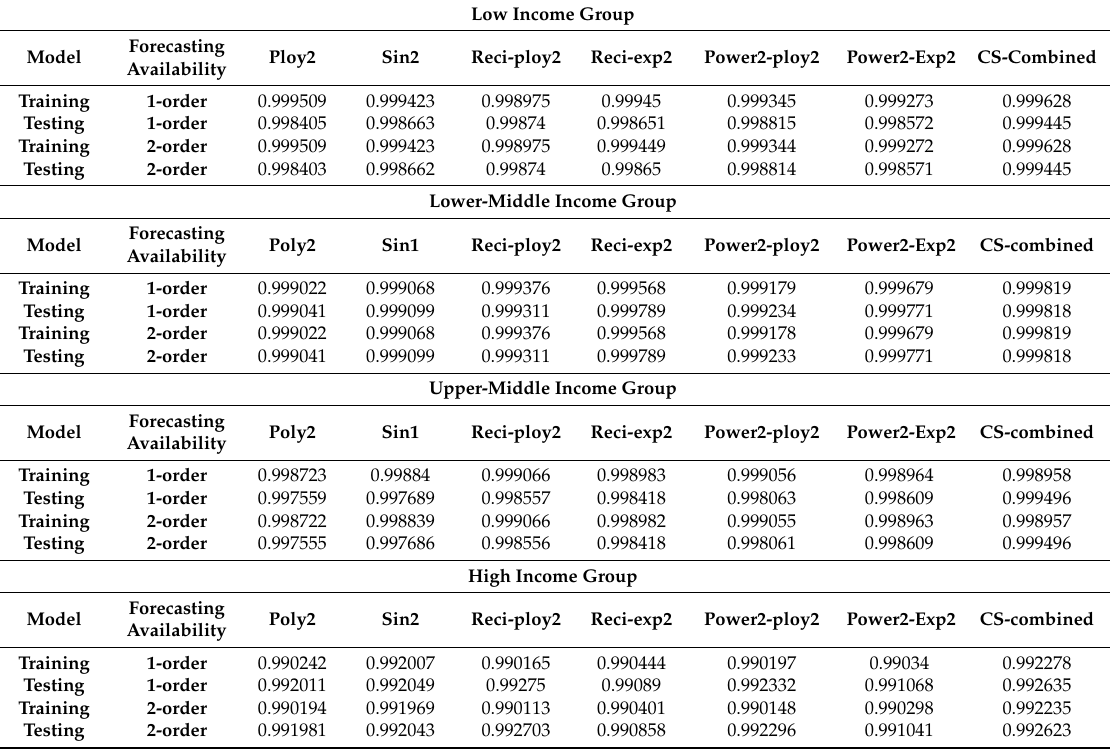
Table 7. Forecasting availability of five different forecasting models for four different income